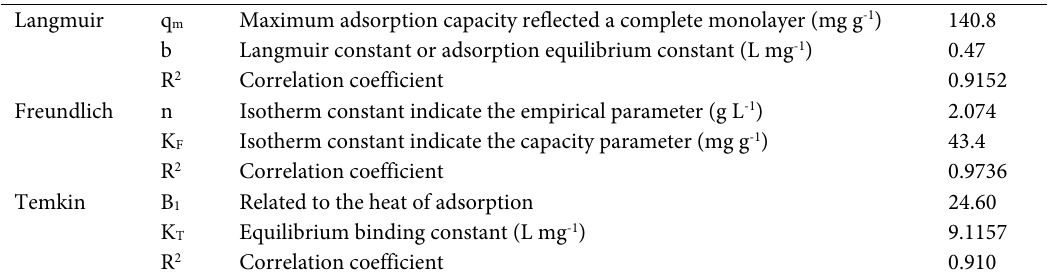
Table 6. Isotherm parameters and correlation coefficients calculated by various adsorption models onto 70 mg of NFNs in 50 mL, pH 5.5 and room temperature.